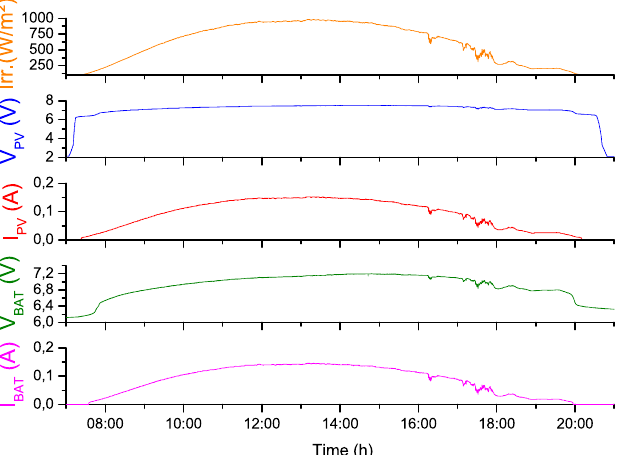
Fig. 17. Irradiance, voltages and currents input/output of the adaptation stage for one day test.